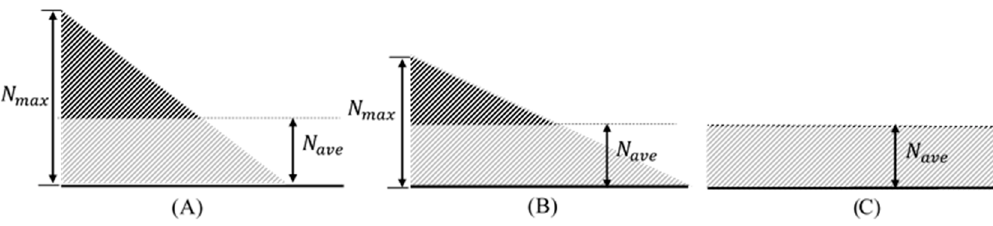
Figure 2. Different non-uniform broadcast fertilization modes, N max is the applied fertilizer maximum quantity at upstream end and Nave is the applied fertilizer average quantity along field plot: ( A ) N max = 2.5 N ave ; ( B ) N max = 2.0 N ave ; ( C ) N max = 1.0 N ave . The total amount of fertilizer applied was the same in all three cases.